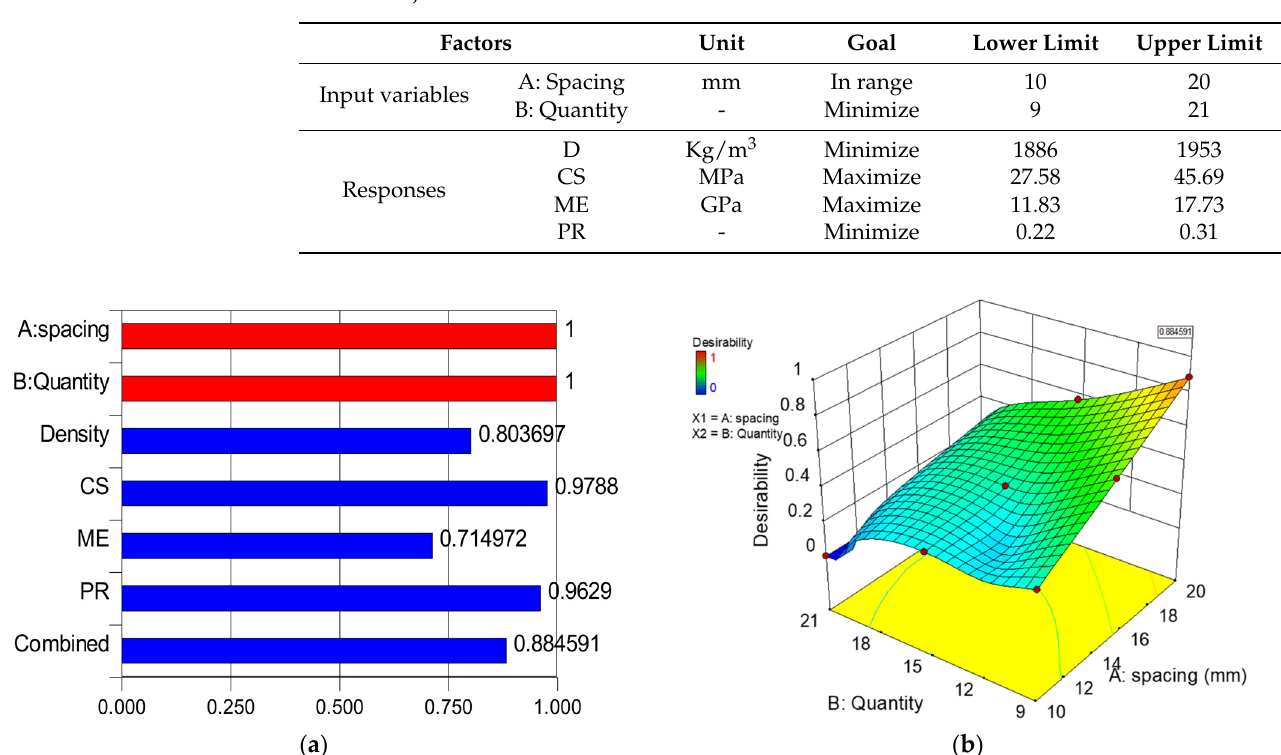
Table 5. Objective functions.